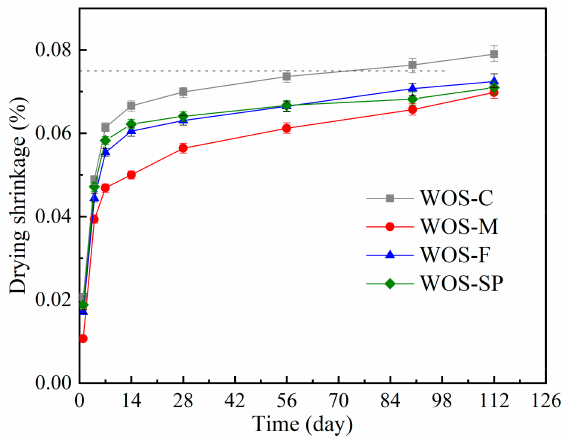
Figure 14. Effect of the particle size and water reducer on the drying